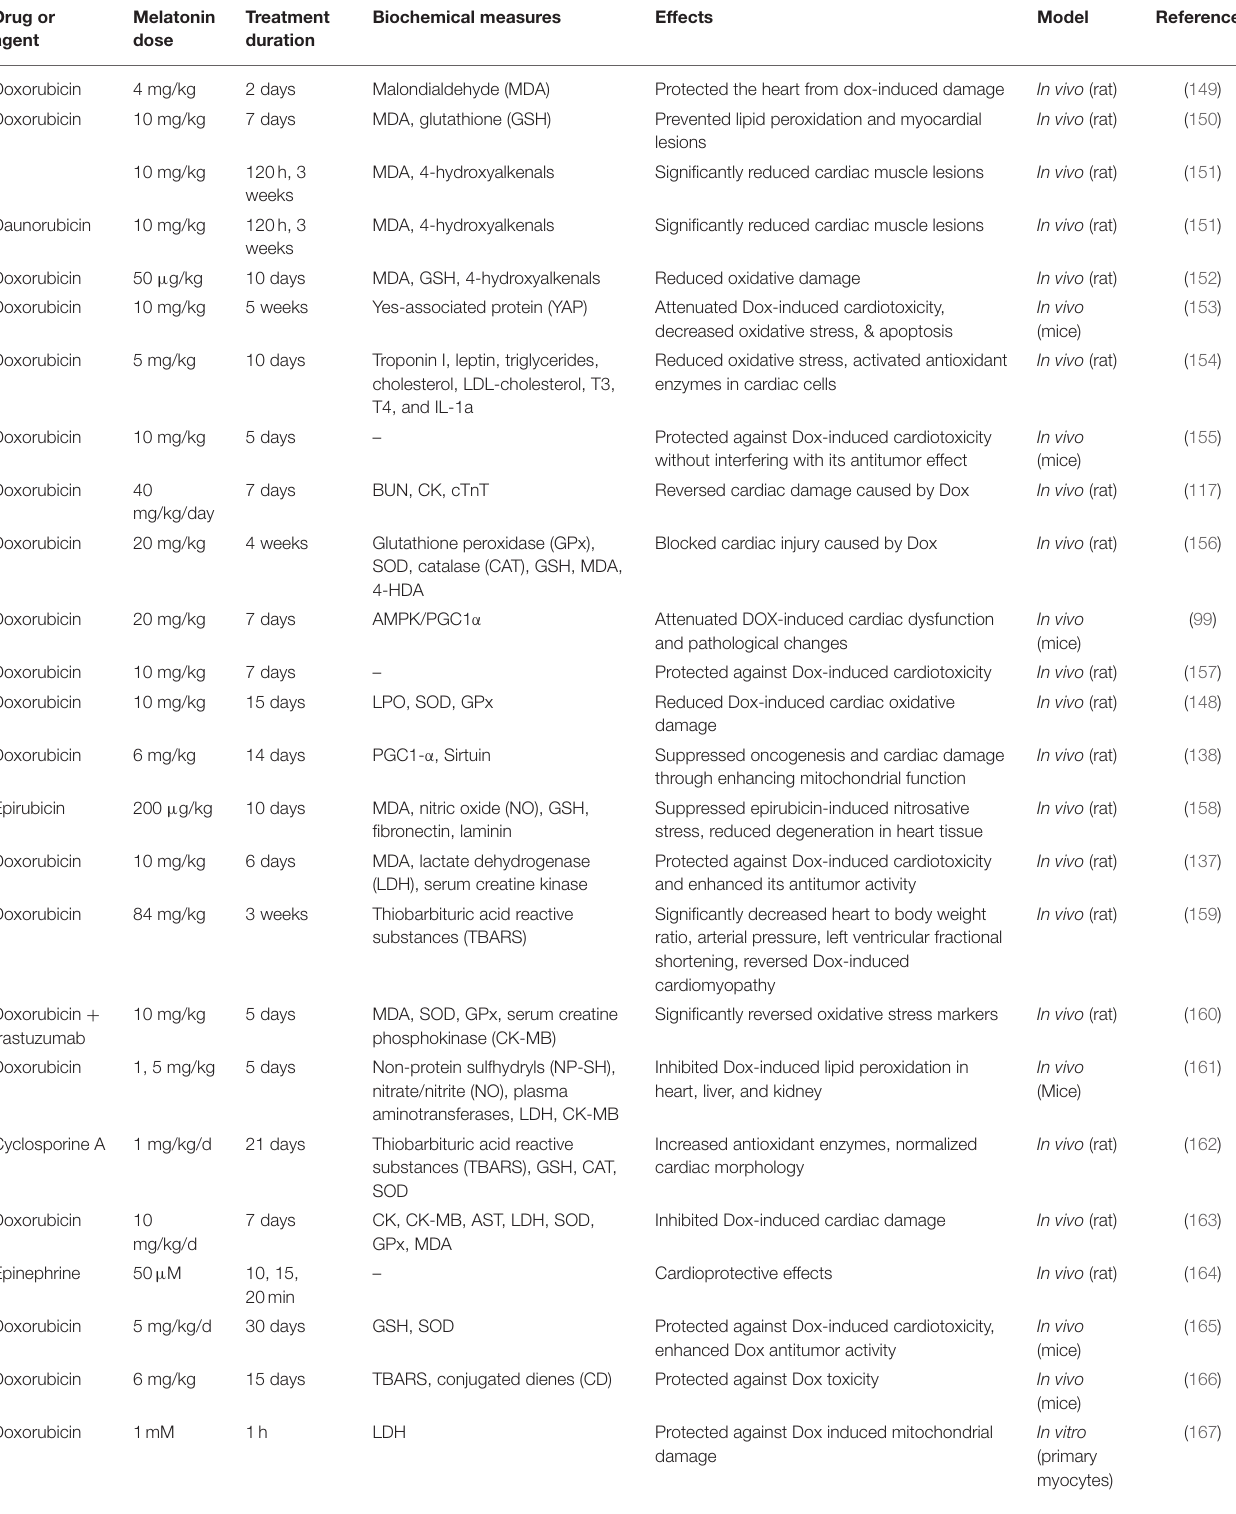
TABLE 1 | Effects of melatonin on drug-induced cardiotoxicity and protection against heart damage. Drug or